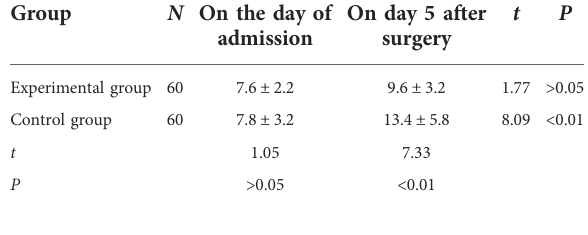
TABLE 5 Comparison of postoperative sleep quality assessment (PSQI) between the two